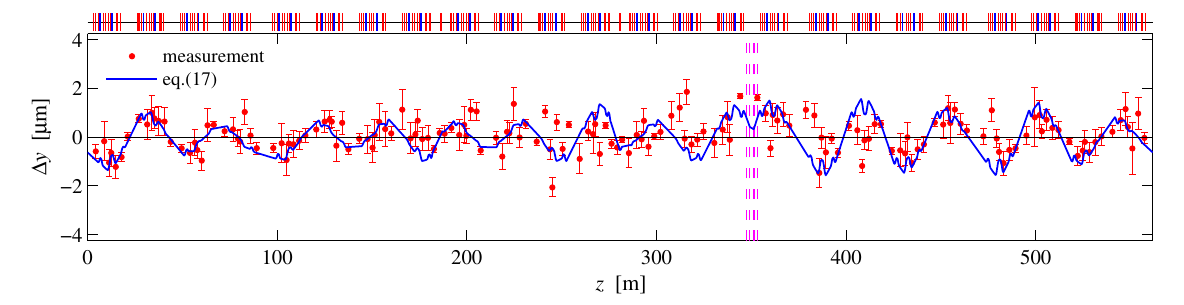
FIG. 10. Orbit deviation: Δ q ¼ 1 . 3 nC, y 0 ¼ 1 mm.